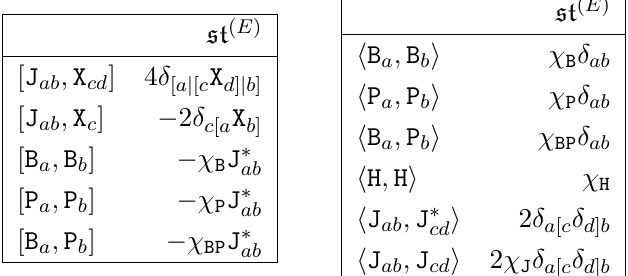
. The bilinear form is ab